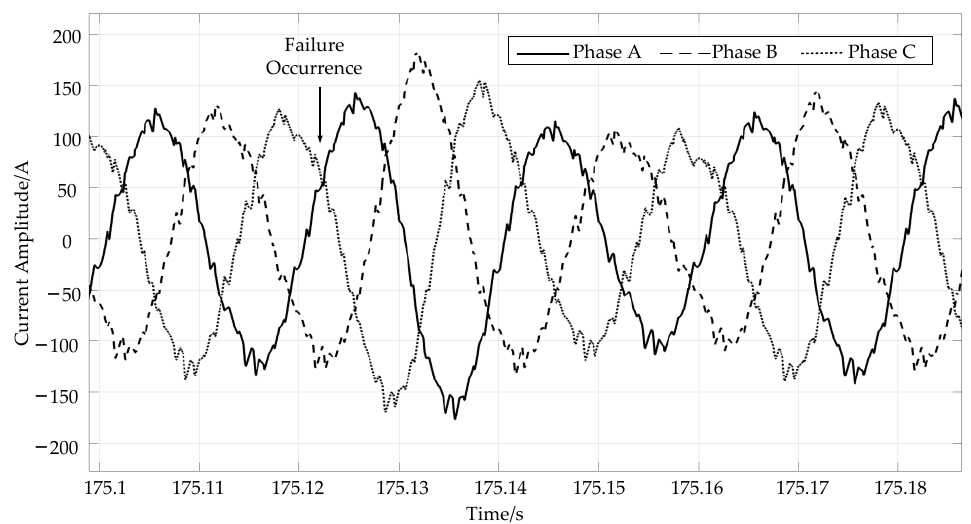
Figure 24. Grid-side current in the case of a single-phase disconnection fault.